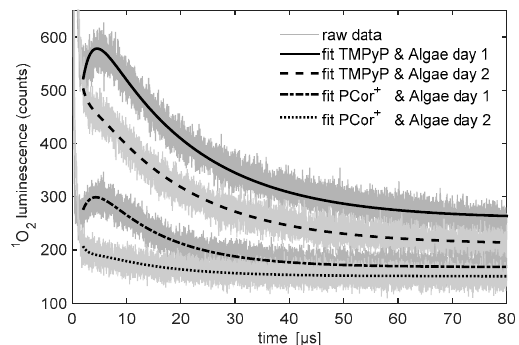
Figure 4. Raw data and fitted model functions.